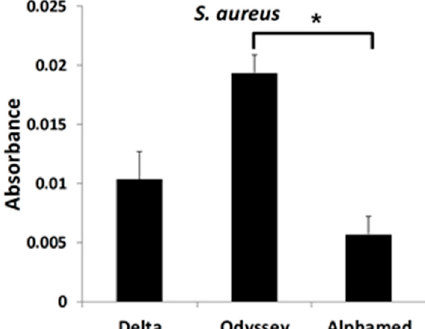
Figure 2. Quantitative measurements of bacterial growth on occluders. Occluders were placed individually in growing S. aureus for seven days. The presence of bacteria on occluders was determined by staining and elution with crystal violet. Absorbance of the eluted crystal violet was measured at an OD of 600 nm. * p < 0.05.